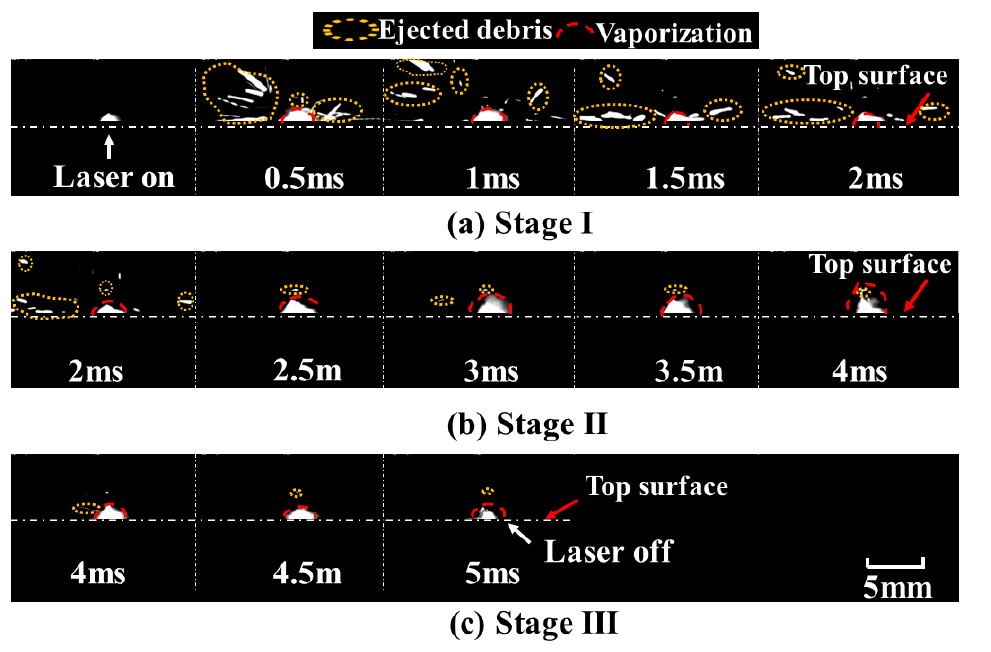
Figure 11. Ejection and vaporization behavior for three stages with a pulse width of 5 ms during single-pulse laser drilling at a peak power of 500 W. ( a ) stage I: 0–2 ms, ( b ) stage II: 2 ms–4 ms, ( c ) stage III: 4 ms–5 ms.